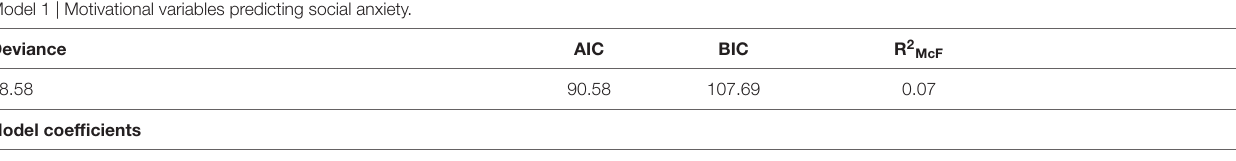
TABLE 2 | Regression analyses predicting different types of language anxiety. Model 1 | Motivational variables predicting social